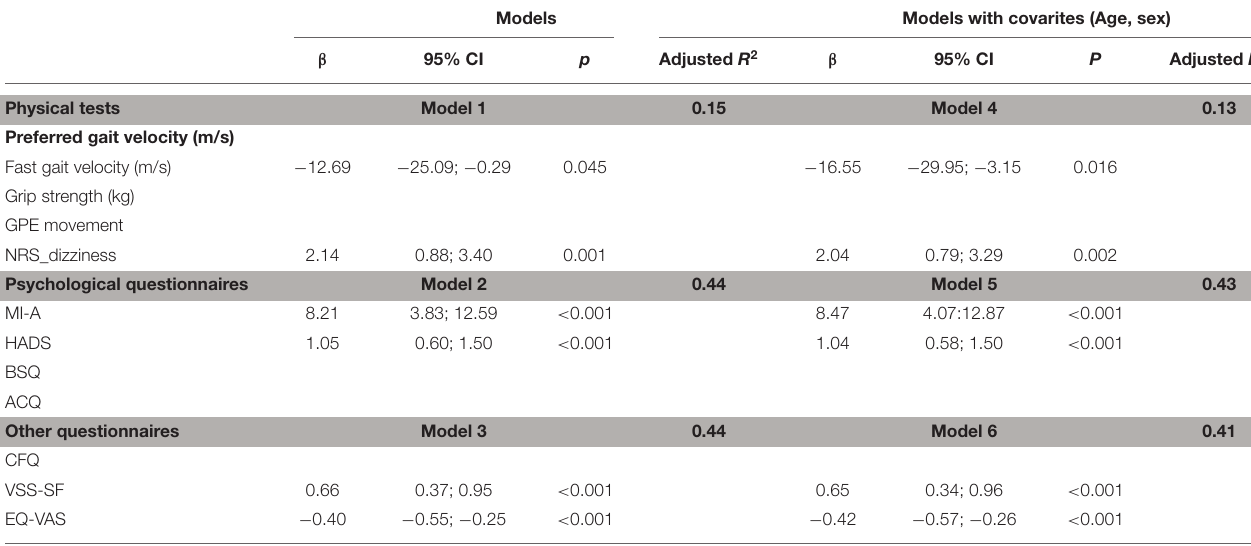
TABLE 3 | Associations between total DHI score and measures in the physical (Models 1 & 4), psychological (Models 2 & 5), and “other” domains (Models 3 & 6) in participants with persistent dizziness. Models Models with covarites (Age, sex)